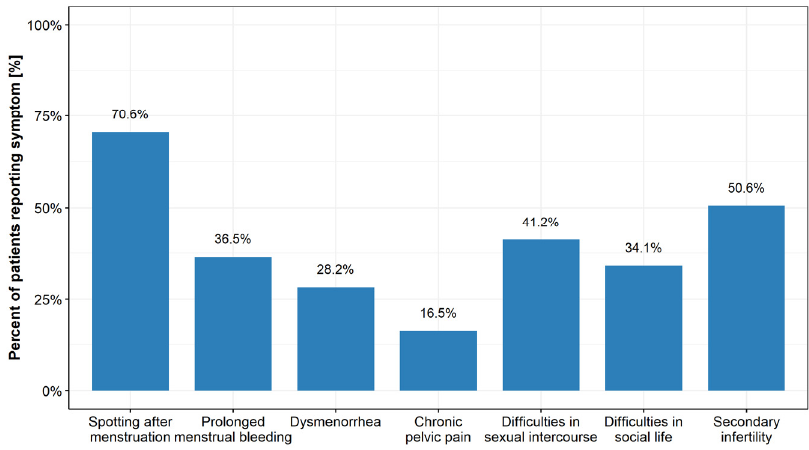
Figure 2. The most common symptoms of the isthmocele reported by patients.